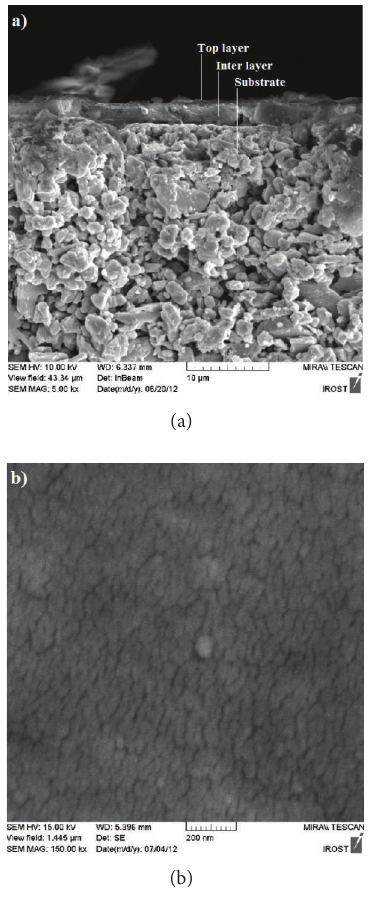
Figure 12: FESEM micrographs of (a) cross-section and (b) top surface of the synthesized anatase